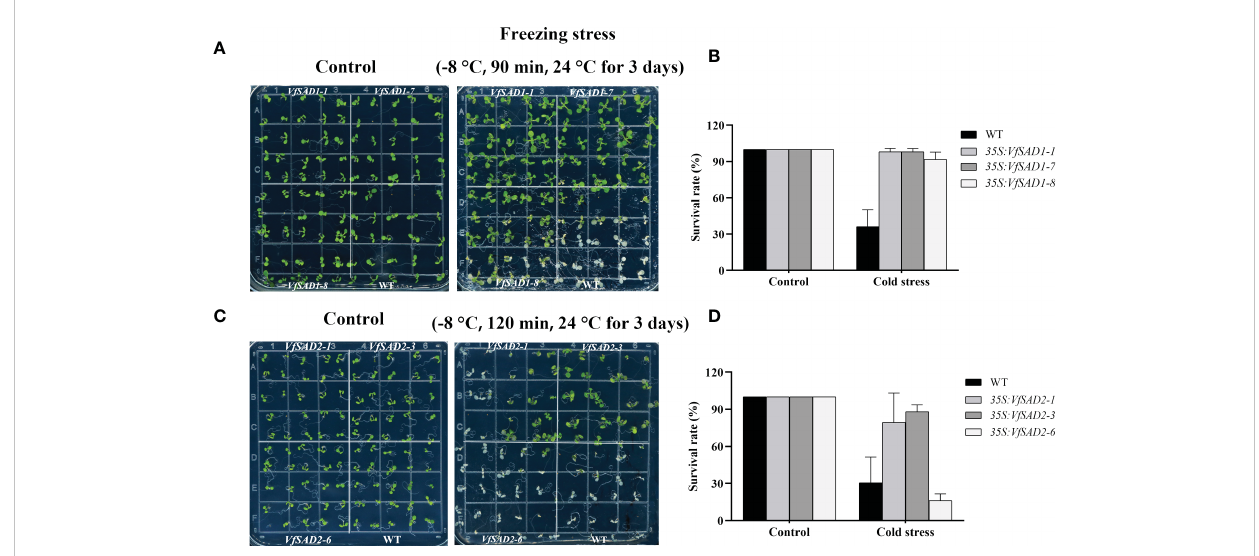
FIGURE 6 VfSAD1 and VfSAD2 enhance the tolerance of Arabidopsis seedlings to low temperature stress. (A, B) Phenotypes (A) and survival rates (B) of the VfSAD1 -overexpressing and WT Arabidopsis plants under normal and freezing treatments ( − 8°C for 90 min); (C, D) phenotypes (C) and survival rates (D) of the VfSAD2 -overexpressing and WT Arabidopsis plants under normal and freezing treatments ( − 8°C for 120 min). The error bar represents the standard deviation (± SD) for setting three biological